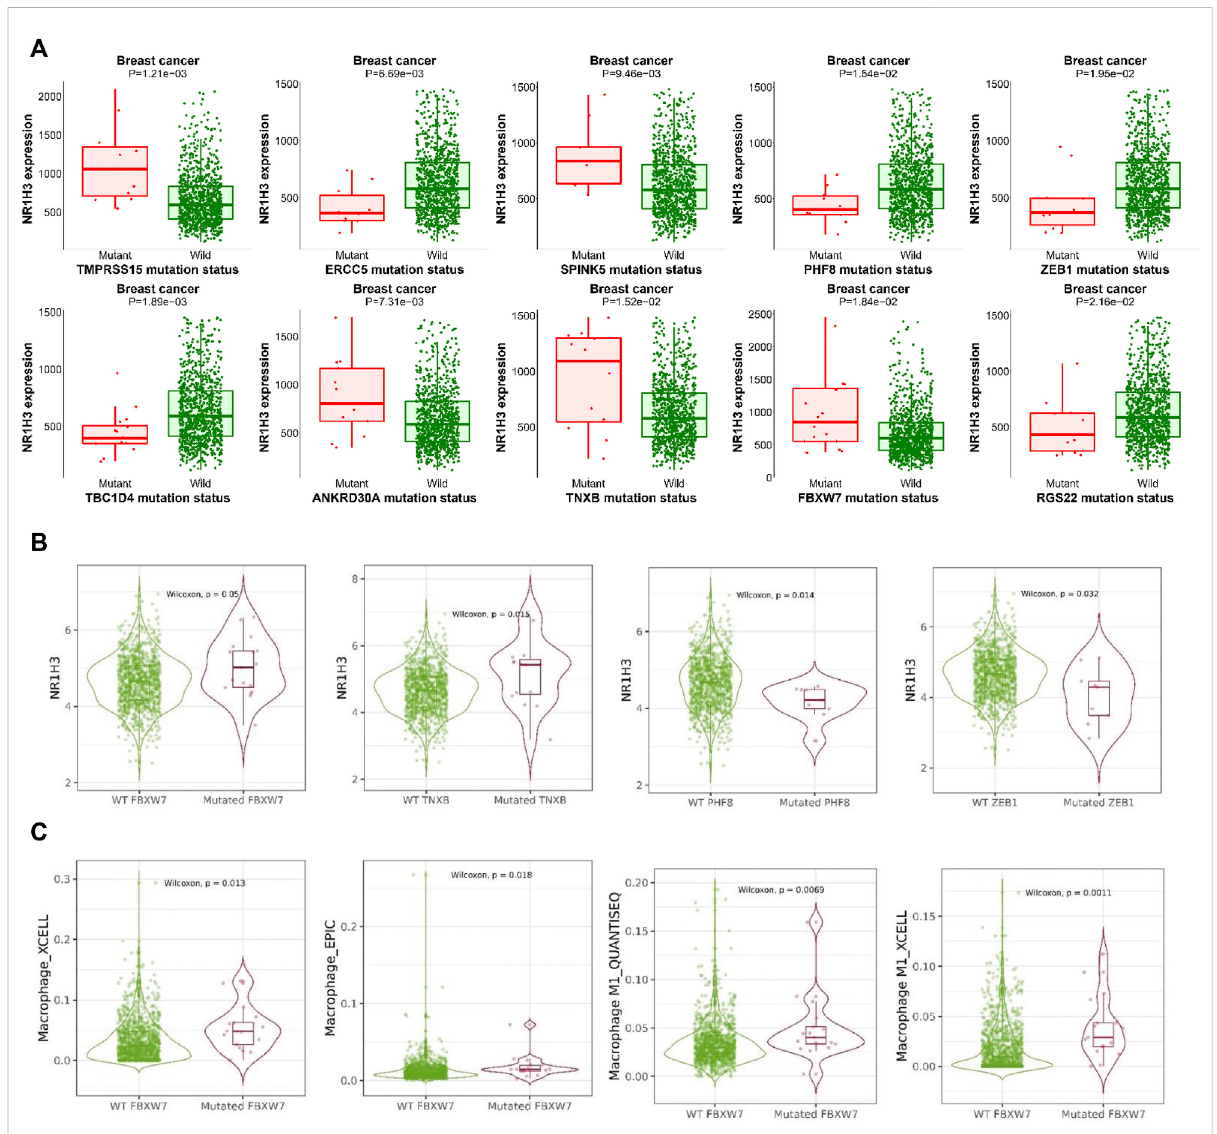
FIGURE 9 The relationship between gene mutation status and NR1H3 expression in breast cancer. (A) The mutant genes that affect the expression of NR1H3geneinthemuTarget database. (B) Therelationship between genemutationstatusand NR1H3expressioninbreastcancerwasveri fi edusing TIMER2. (C) Higher in fi ltration of macrophage was shown in the FBXW7 mutant group, compared with the wild type